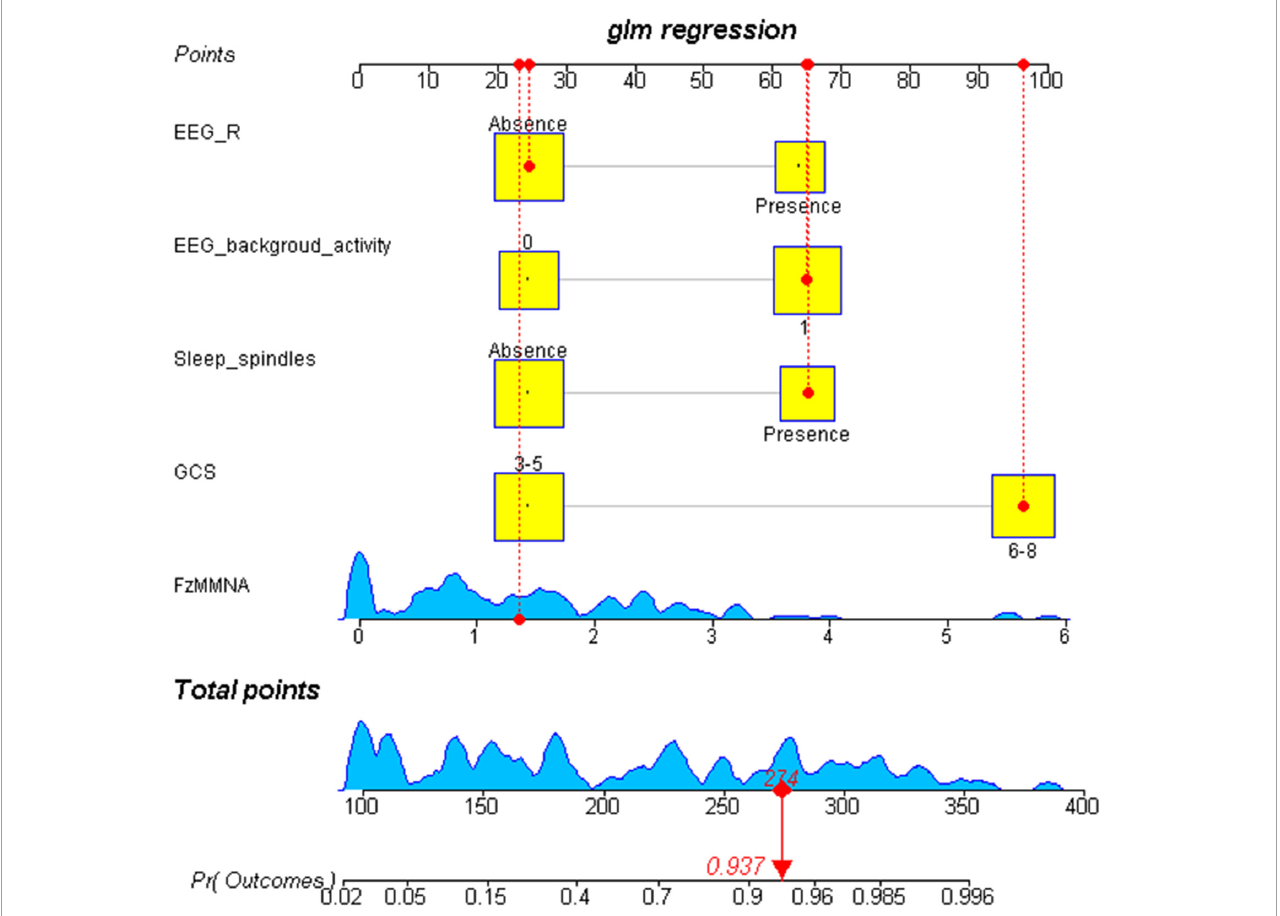
FIGURE4 Visualization nomogram to predict the consciousness recovery of comatose patients after acute brain injury. The total score of each variable and the corresponding probability of consciousness recovery of comatose patients can be visualized in the nomogram. For example, a case is shown in the nomogram (red). This case represents a comatose patient with GCS scores of 8, the EEG-R is absent, the sleep spindles is present, the EEG background activity at level 3, and the FzMMNA is 1.42 µ V. In consideration of these five variables, the total score for this patient was 274, corresponding to a probability of regaining consciousness of 0.937. Number 0 in EEG background activity refers to diffuse slowing (DS), low voltage (LV), and Alpha coma. Number 1 in EEG background activity refers to normal, mildly abnormal (MiA), moderately abnormal (MoA), and spindle